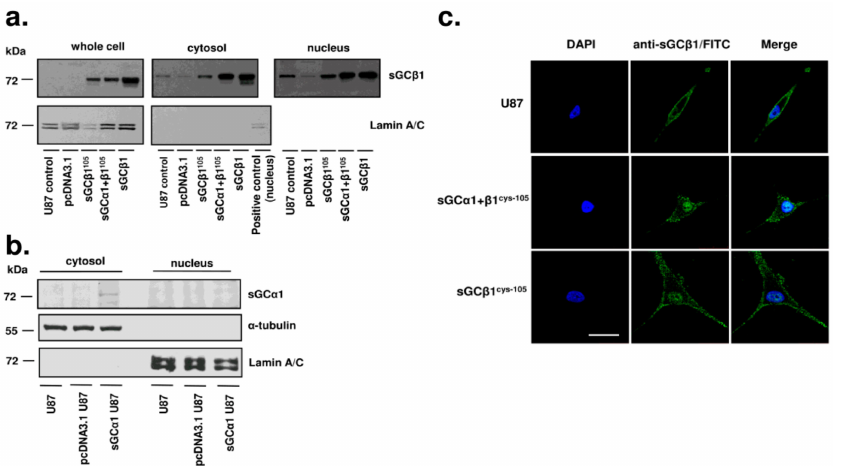
Figure 4. Subcellular localization of sGC β 1 and sGC α 1 in human glioblastoma cells. ( a ) Immunoblot- ting analysis of U87 cells, U87 cells transfected with pcDNA3.1D control vector or the vectors for overexpression of sGC β 1 Cys105 , sGC α 1 plus sGC β 1 Cys105 , and sGC β 1. An anti-sGC β 1 antibody was used to detect the distribution of sGC β 1 in the whole cell extract (left panel), cytosol (middle panel), and nucleus (right panel). Detection by an antilamin A/C antibody was used as a loading control. ( b ) Immunoblotting analysis of untransfected human glioblastoma U87 cells, U87 cells transfected with pcDNA3.1D control vector alone, and U87 cells with sGC α 1 overexpression. An anti-sGC α 1 an- tibody was used to detect the α 1 subunit in the cytosol and nucleus. The lack of cross-contamination between the nucleus and cytoplasm was confirmed using the nuclear marker lamin A/C and cy- toplasmic marker α -tubulin. ( c ) Immunostaining of sGC β 1 in control U87 cells (upper panel), an sGC α 1 + β 1 Cys105 –overexpressing stable clone (middle panel), and an sGC β 1 Cys105 –overexpressing stable clone (bottom panel). Blue represents the nuclei stained by DAPI, and green represents FITC staining of sGC β 1. The images were acquired by confocal microscopy at 600 × magnification. Scale bars: 20 µ